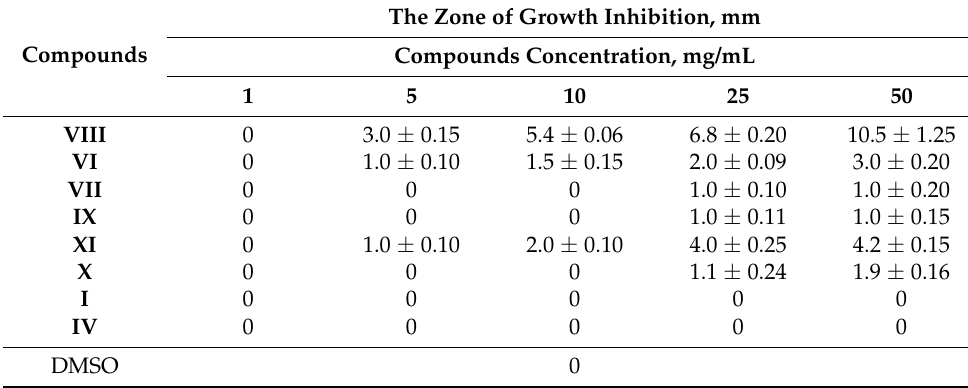
Table 4. Fungicidal properties compounds against Candida tropicalis .